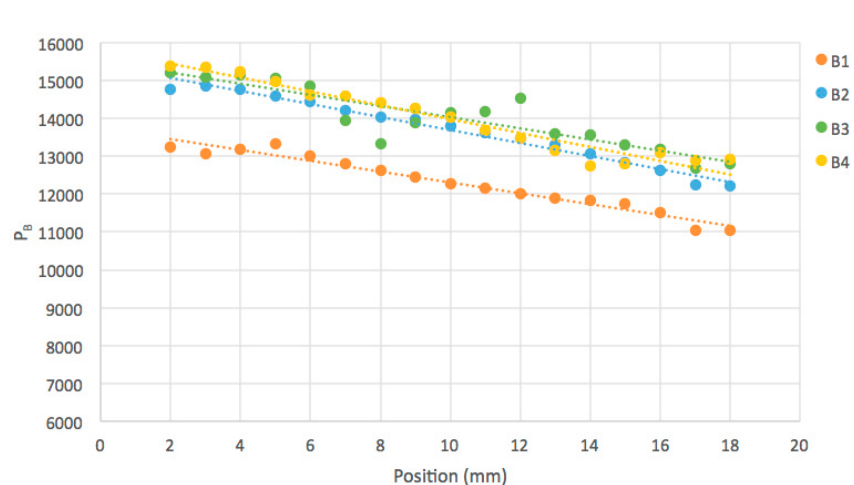
Figure 17. The radiation-induced fluorescence as a function of penetration depth along the x-ray beam for the four beams shown in Figure 15. The ratios of the value at 18 mm to that at 2 mm are listed in